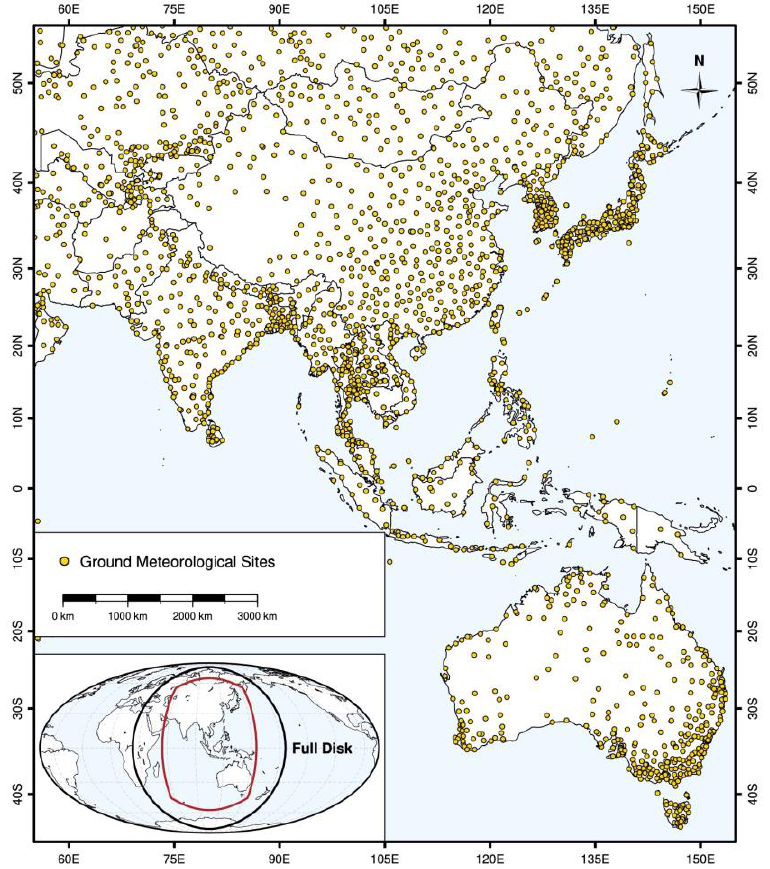
Figure 1. Map of the study areas overlaid with the ground meteorological sites used for developing SAT estimation models. The inset map on the lower left shows the full-disc observation area of the FY-4A geostationary satellite, which is delimited by the black line, and the spatial extent of study areas is denoted by the red line.